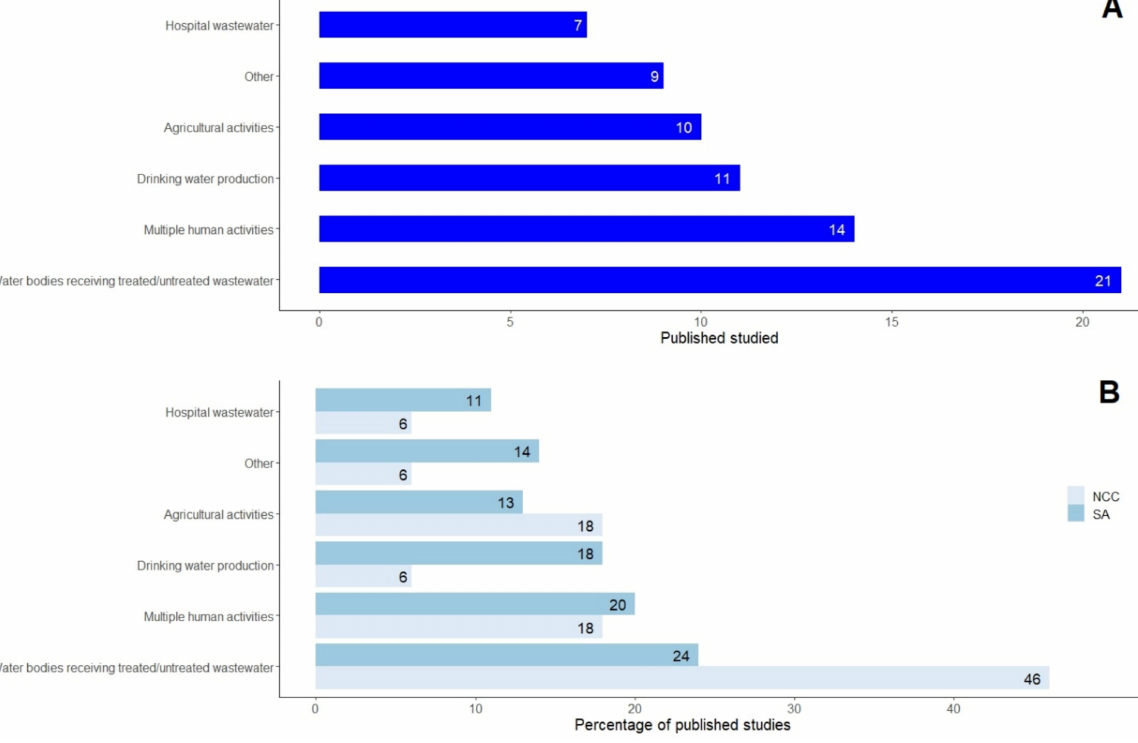
Figure 3. Anthropogenic activities affecting water bodies. ( A ) Number of articles published on water use. ( B ) Percent of publications by region. Region 1: North America, Central America and the Caribbean (NCC); Region 2: South America